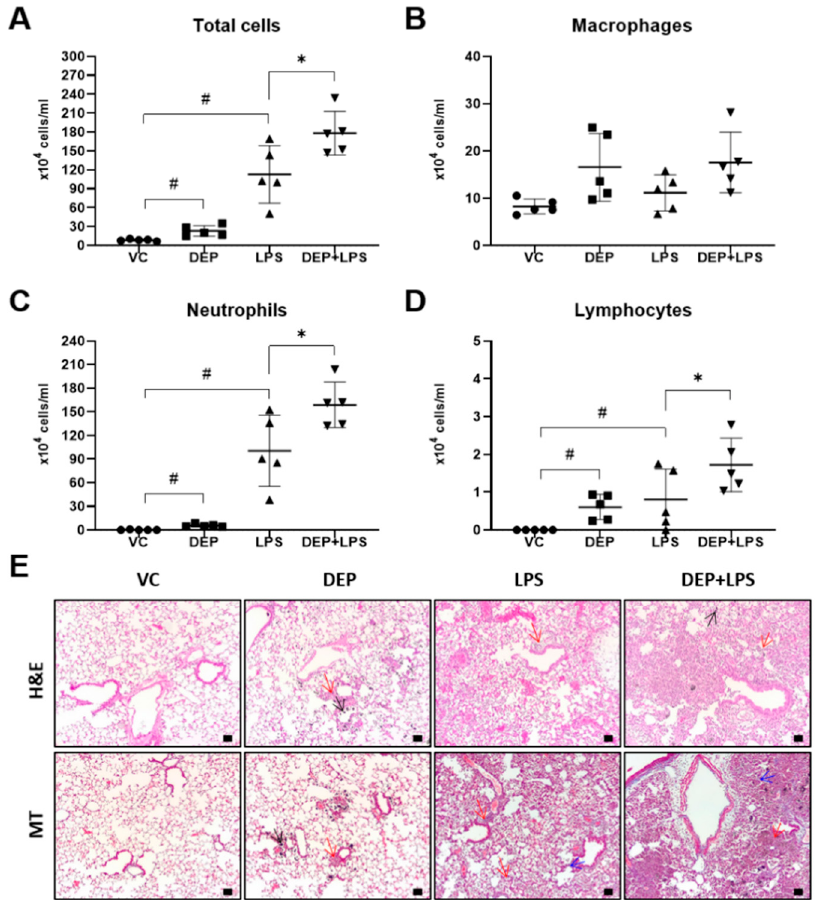
Figure 3. ( A – D ) Cellular changes in the bronchoalveolar lavage (BAL) fluid and ( E ) representative hematoxylin and eosin (H&E) and Masson’s trichrome-stained images of the lung sections from the vehicle control (VC), DEP, LPS, and DEP pre-exposed and LPS-instilled (DEP + LPS) groups. Black, red, and blue arrows indicate particle-pigmented alveolar macrophages, inflammatory in- filtration, and collagen deposition, respectively. Scale bars = 50 µ m. Data represent means ± SD (n = 5 per group). # p < 0.05 vs. VC, * p < 0.05 vs. LPS